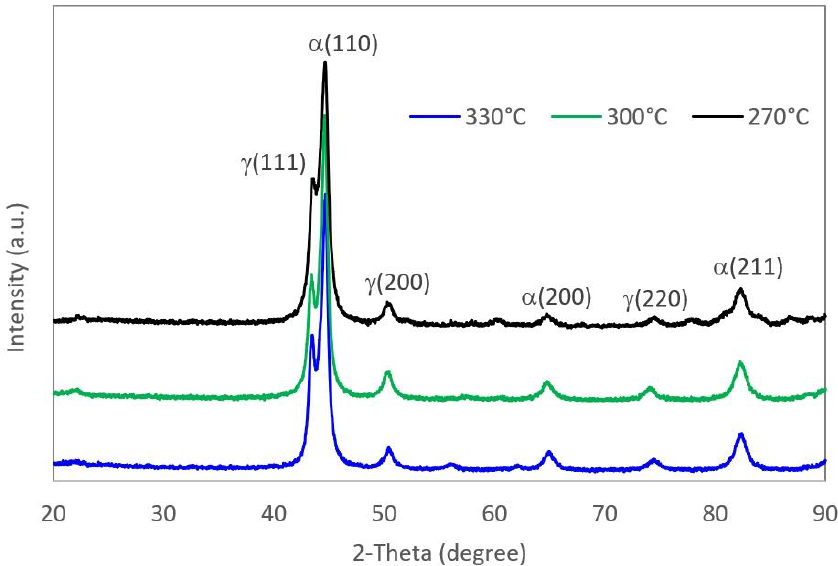
Figure 6. XRD patterns of ADI samples heat treated at 270 °C, 300 °C, and 330 °C showing predom- inant phases.